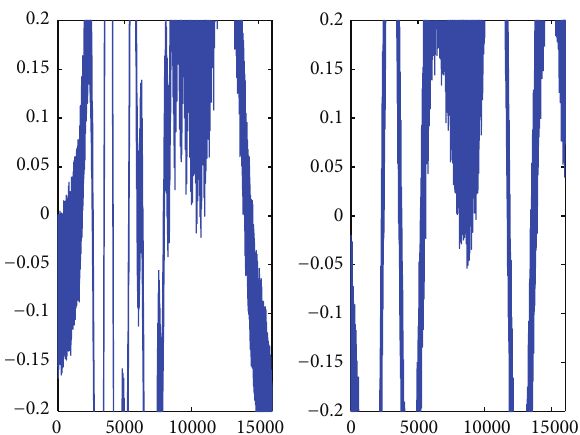
Figure 3: Decrypted signals of the proposed method with mismatch of secret